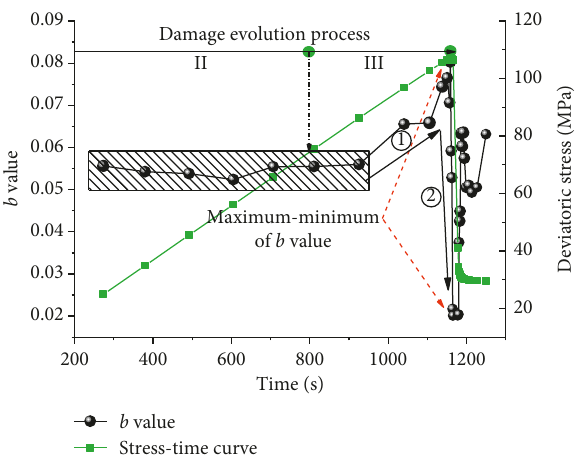
Figure 16: Stress time b value correlation change rule sz-22.